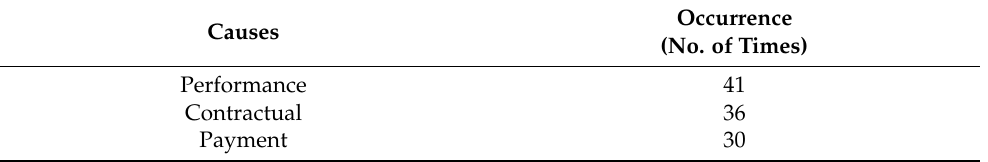
Table 3. Ranking of Cause of